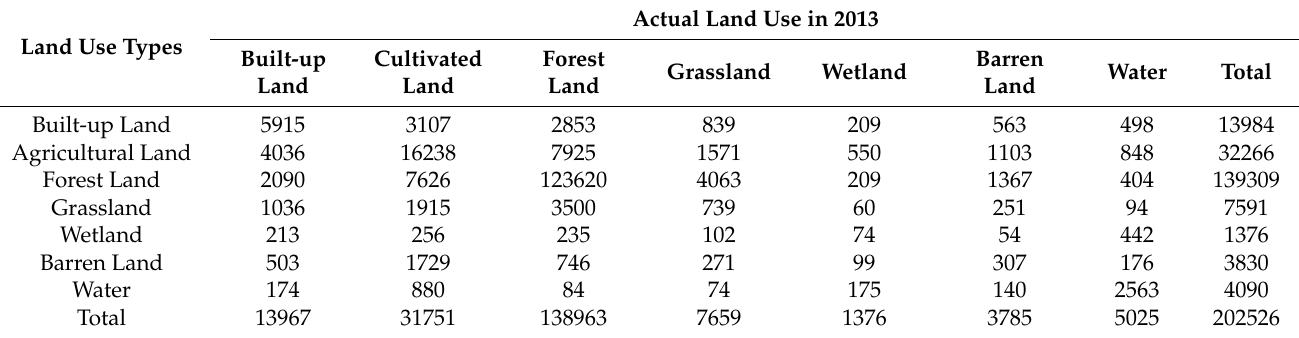
Table 5. Confusion matrix of the predicted land use versus the actual land use in 2013.